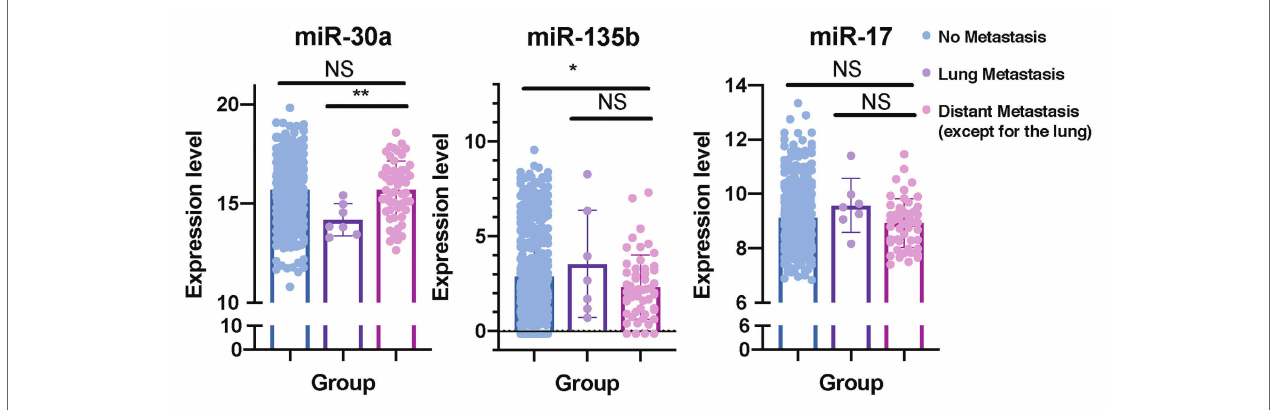
FIGURE 7 | miR-30a and miR-135b have unique roles in lung metastasis of BC. Dot plots were plotted to show the distributions of miR-30a, miR-135b, and miR-17 in BC patients with distant metastasis except for the lung, BC patients with lung metastasis only, and BC patients without metastasis. miRNA, microRNA; BC, breast cancer. * p < 0.05; ** p <